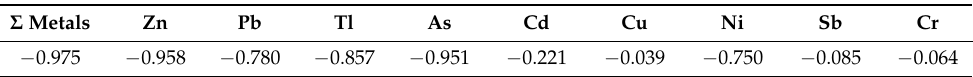
Table 2. Pearson correlation coefficients between inverted resistivity and selected elements. Σ of